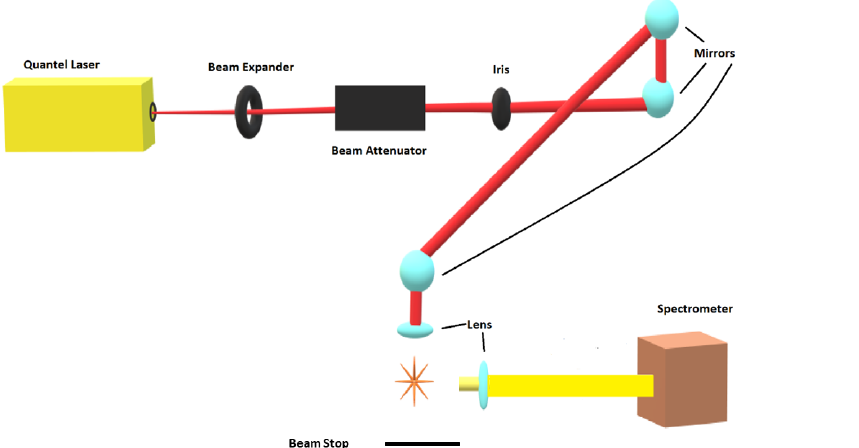
Figure 1. Experimental arrangement for laser-induced breakdown